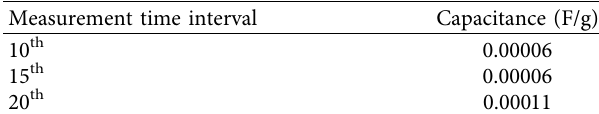
Table 2: Recorded Cp